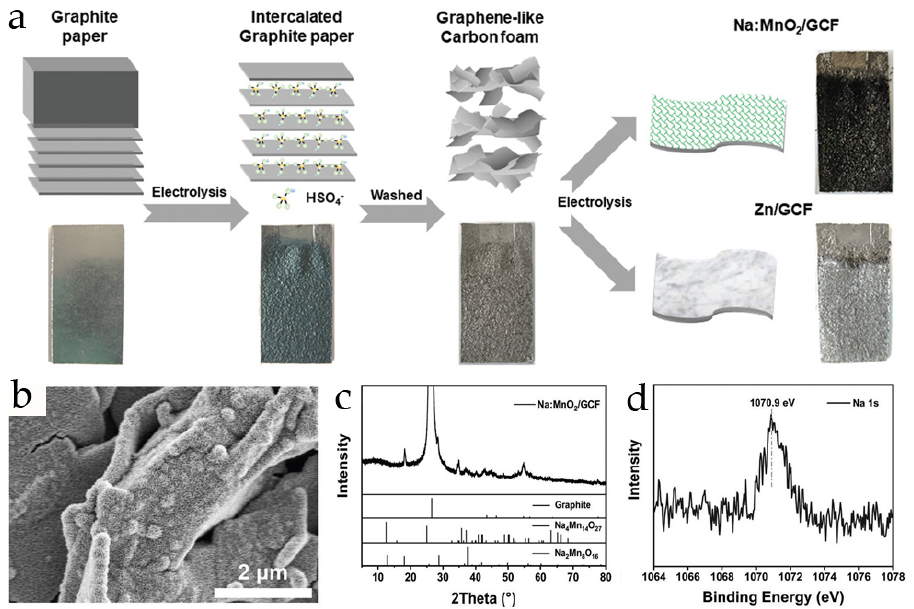
Figure 3. ( a ) The synthesis scheme of the GCF from the raw graphite paper and the photographs of the samples through the synthesis route. ( b ) The surface SEM of the Na:MnO 2 /GCF electrode. ( c ) XRD patterns of the Na:MnO 2 /GCF electrode. ( d ) Na 1s core-level XPS spectra of the Na:MnO 2 /GCF electrode [33].